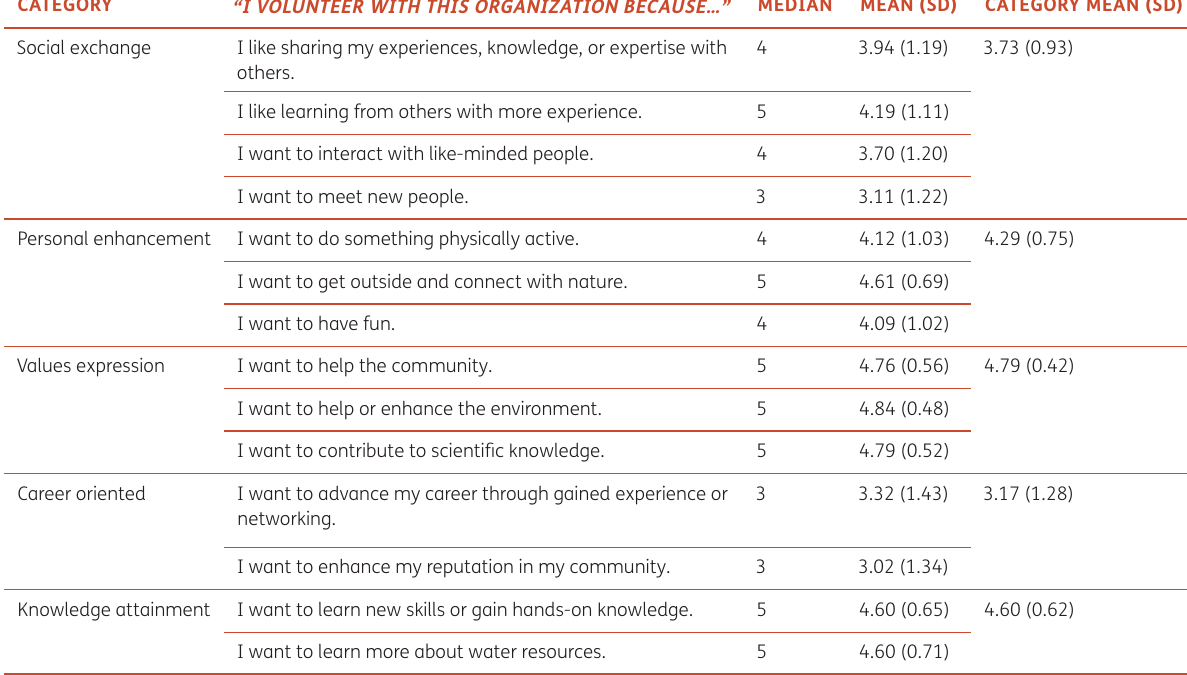
Table 3 Descriptive statistics of motivational statements and factors.